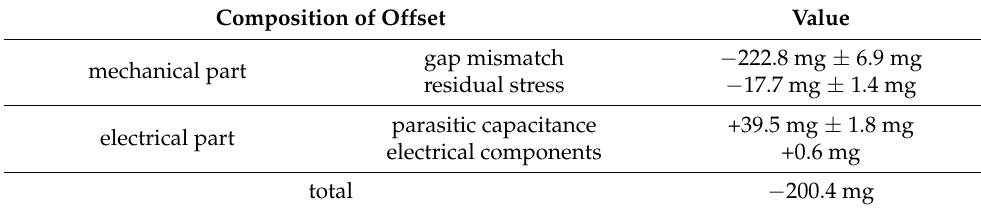
Table 5. Decomposition results of